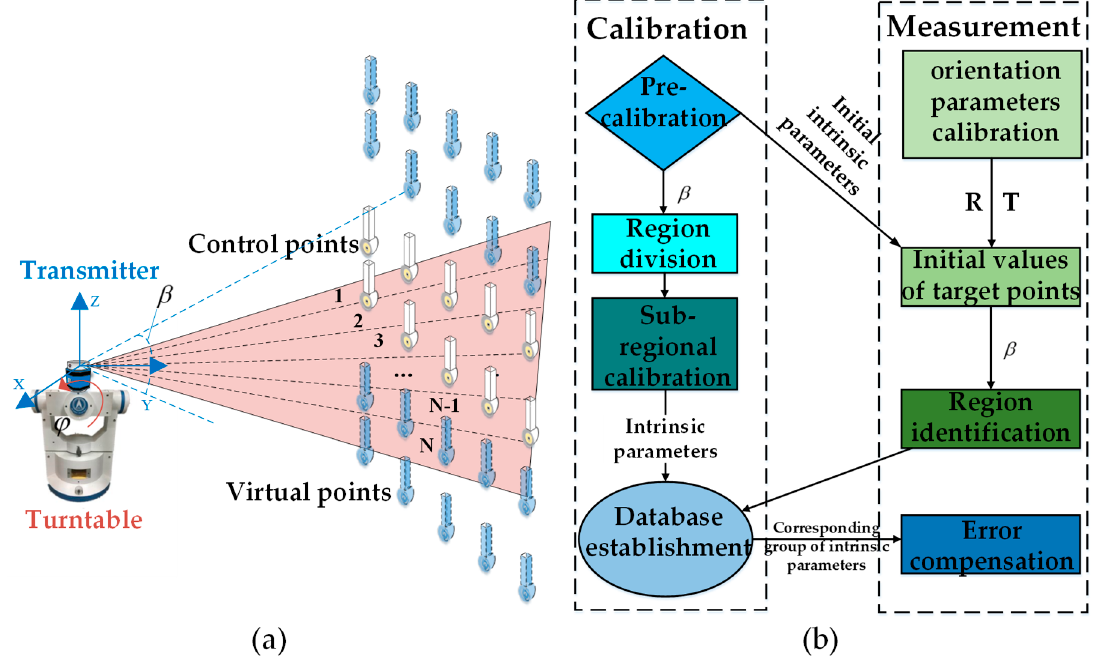
Figure 3. The sub-regional calibration mechanism and the error compensation algorithm. ( a ) The experimental schematic; ( b ) The algorithm